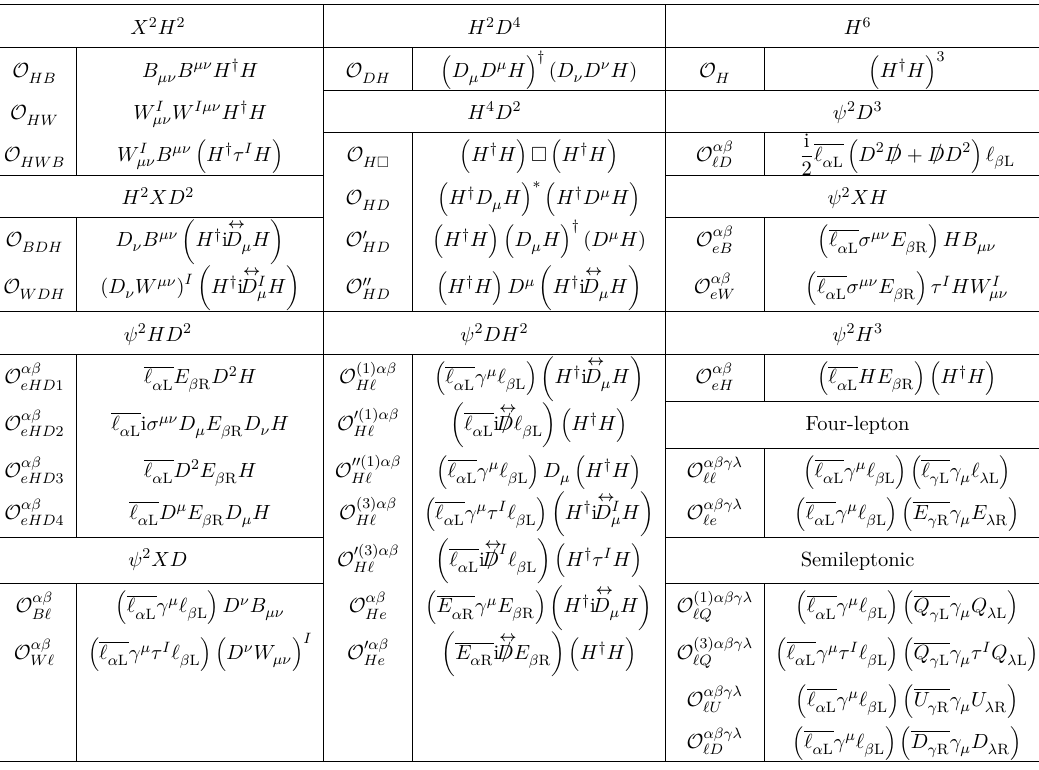
Table 1 . Dimension-six operators at the one-loop level induced by heavy Majorana neutrinos in the type-I seesaw model in the Green’s basis, where the Hermitian conjugates of the operators in the classes ψ 2 HD 2 , ψ 2 XH and ψ 2 H 3 , as well as those of the four-fermion operators, have not been listed